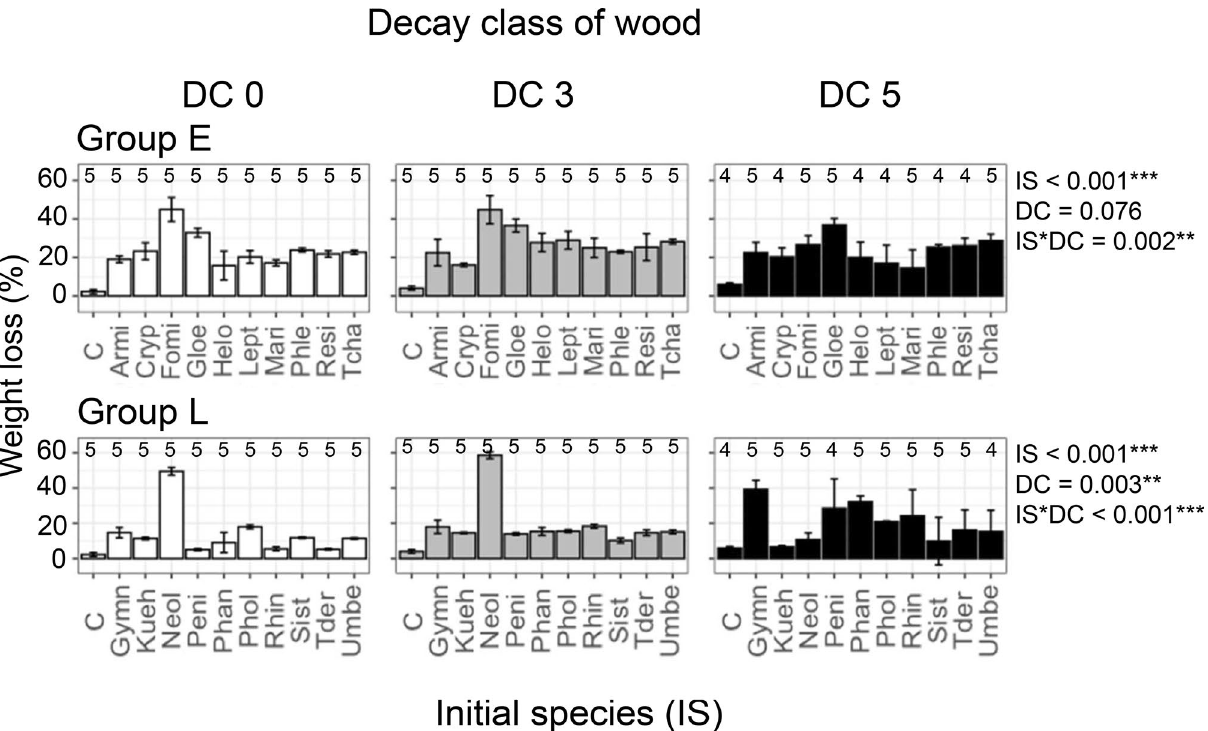
Figure 4. Effect of initial fungal species on wood decomposition 5 months after all species were introduced. Numbers on the bars indicate replicate number of the sample. P values and bar colors as in Fig. 2.